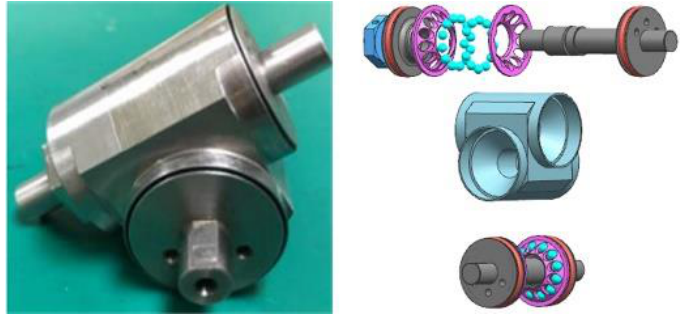
Figure 2. Prototype and explosion diagram of joint.